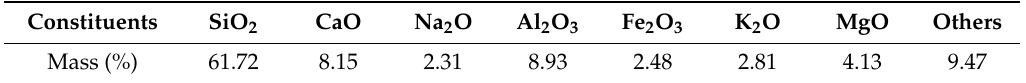
Table 4. Chemical properties of